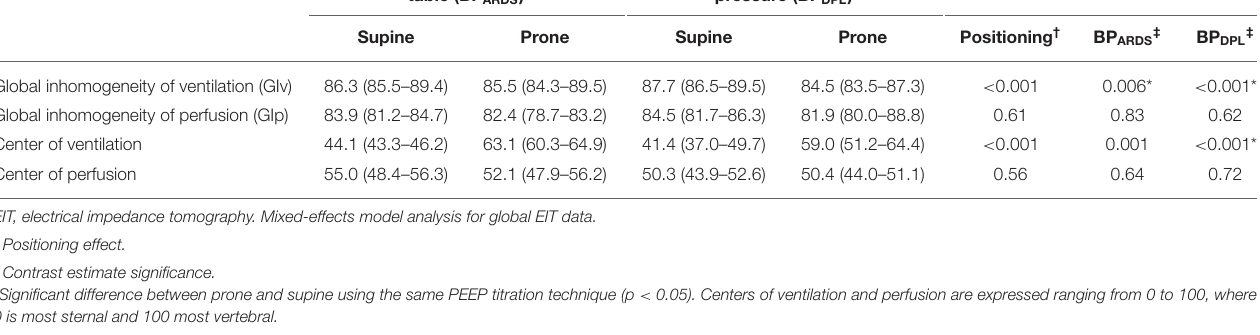
PEEP set targeting the lowest transpulmonary table (BP ARDS )